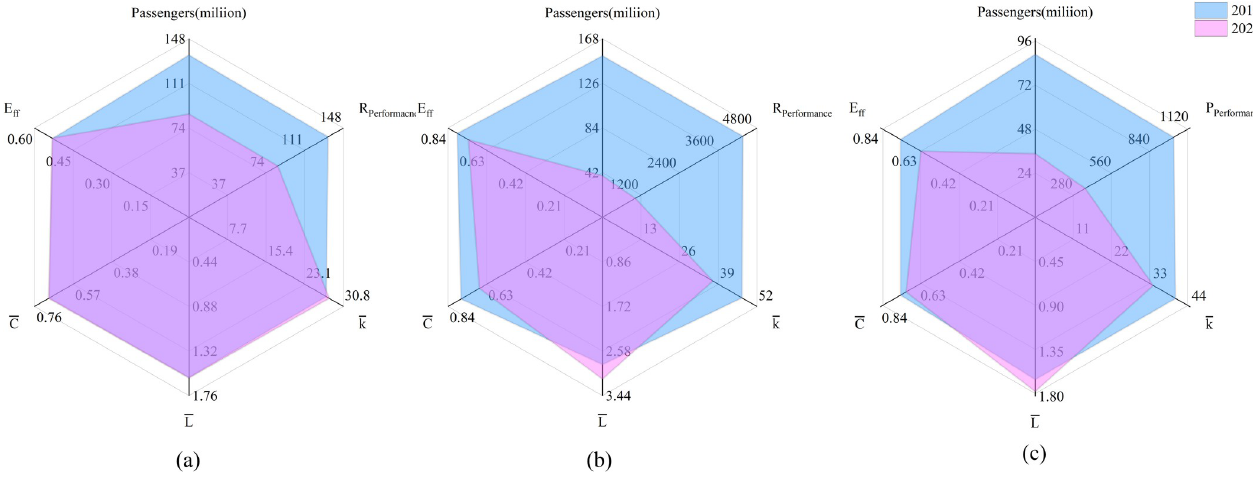
Fig 4. Topological indicators of changes to airport networks during COVID-19.